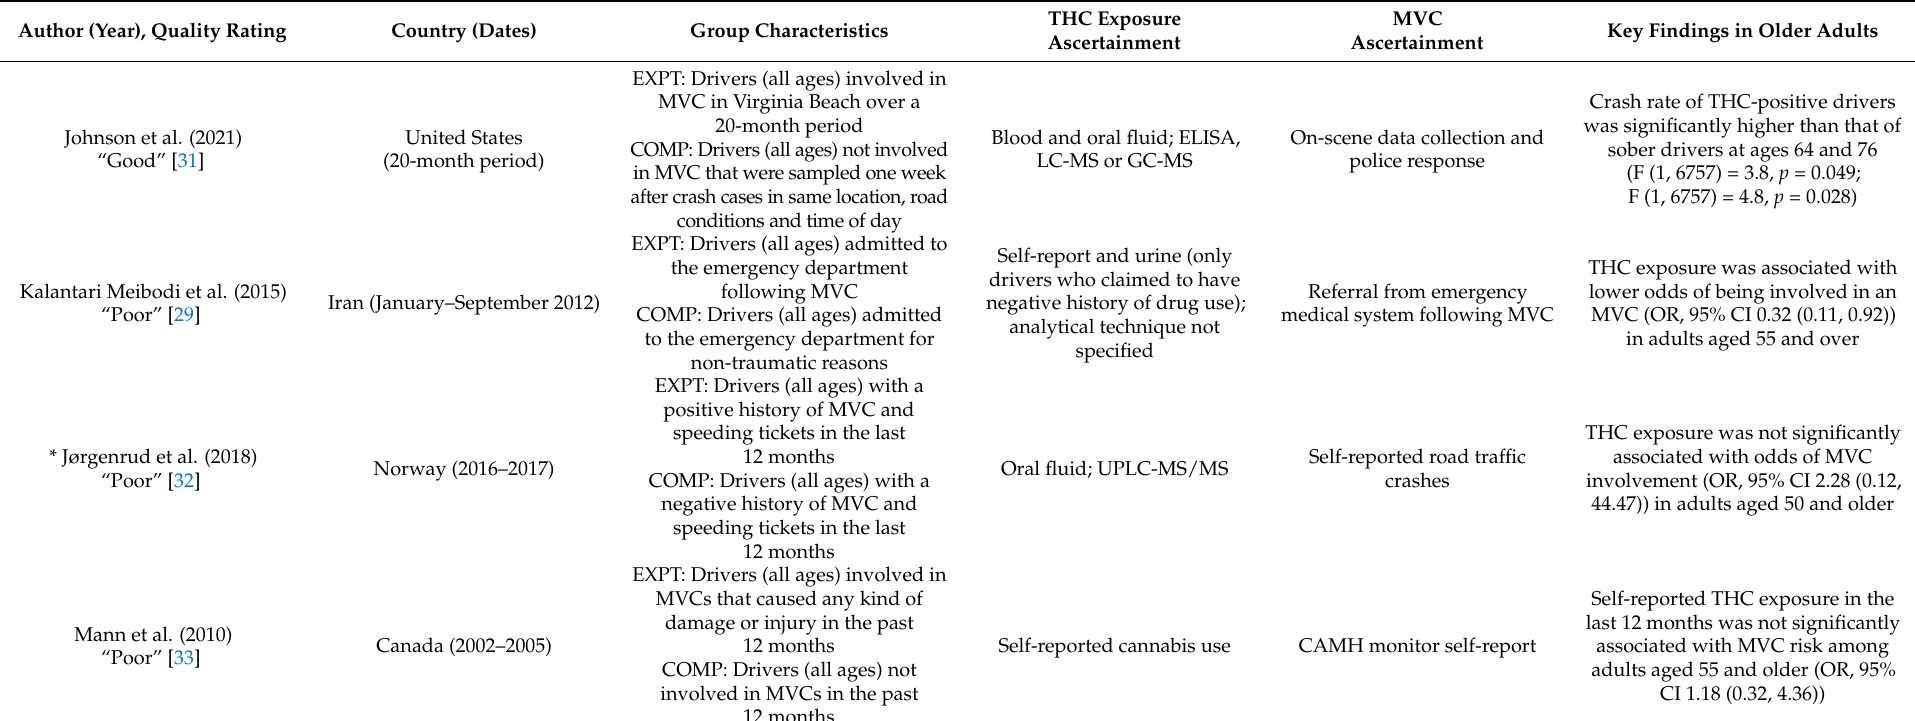
Table 2. Characteristics and Results of the Included MVC Risk